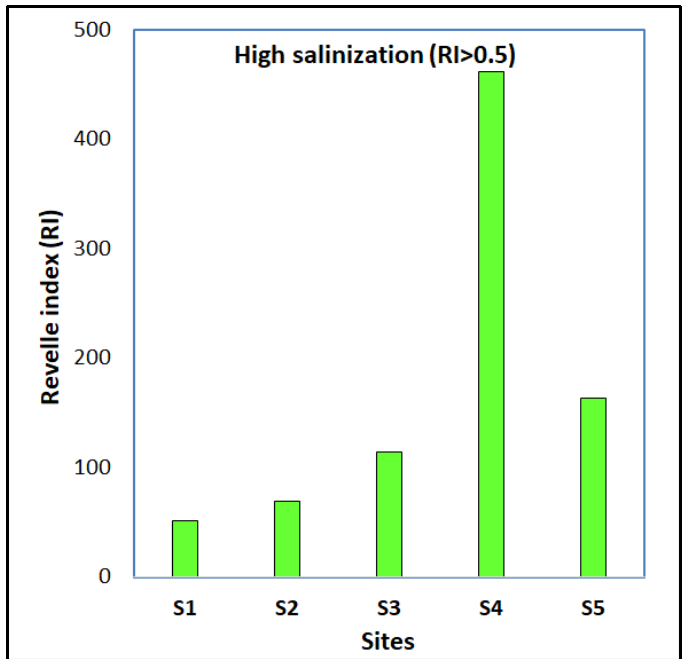
Figure 5. The Revelle index (RI) for the groundwater samples.